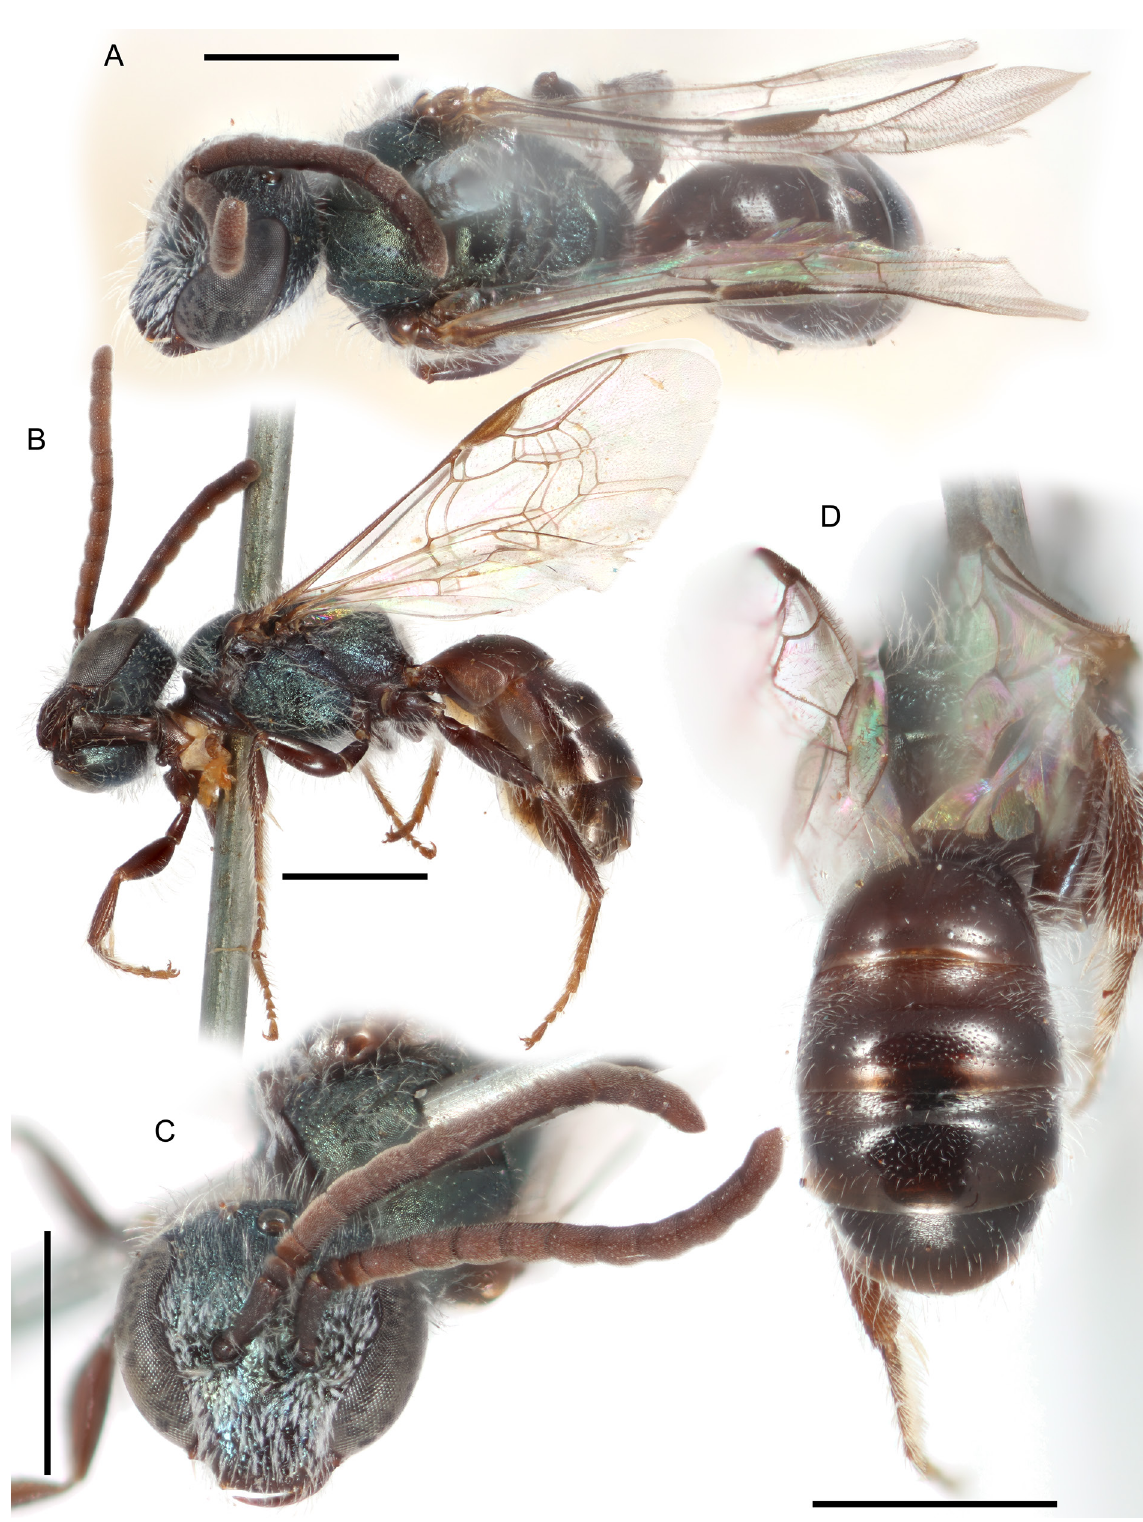
Fig. 82. Lasioglossum ( D. ) tessellatosum sp. nov., ♂. A . Dorsal habitus. B . Lateral habitus. C . Face. D . Metasoma. Scale bars: 1